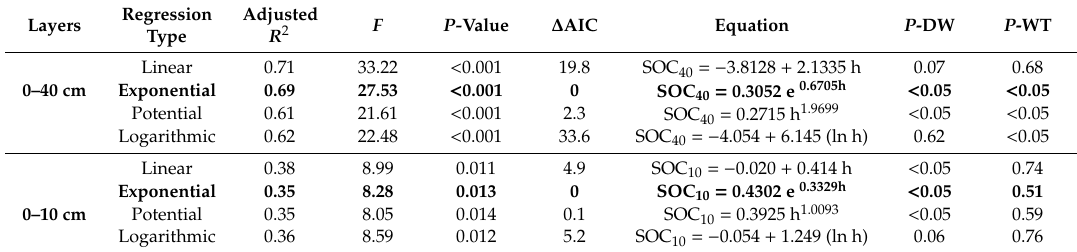
Table 3. Allometric equations used to estimate the SOC content (kg / m 2 ) (SOC 40 , 0–40 cm; SOC 10 , 0–10 cm) for the Quercus ilex-Q. suber forest plantation in Andalusia (Southern Spain). Independent variables (h = total height, m). Adjusted determination coe ffi cient ( R 2 ), P -value, F , ∆ AIC, Durbin–Watson test for residuals autocorrelation (DW) and White test for homocedasticity (WT). Main characteristics of the regressions of the weighted SOC content (kg / m 2 ) versus the total tree height (m), for the soil depths 0–40 cm (SOC 40 ) and 0–10 cm (SOC 10 ).